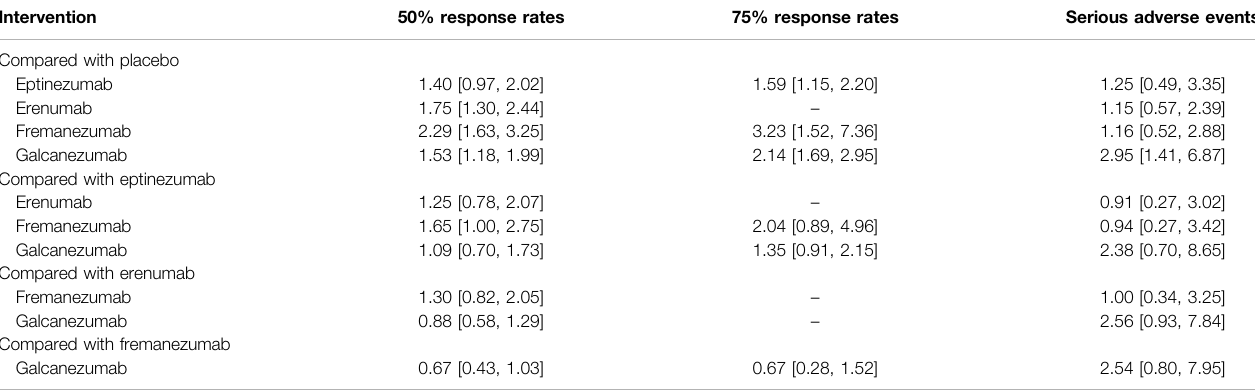
TABLE 2 | Pooled RR and relative CrI of 50% response rates, 75% response rates, and serious adverse events derived from network meta-analysis with different treatment regimens in patients with migraine.